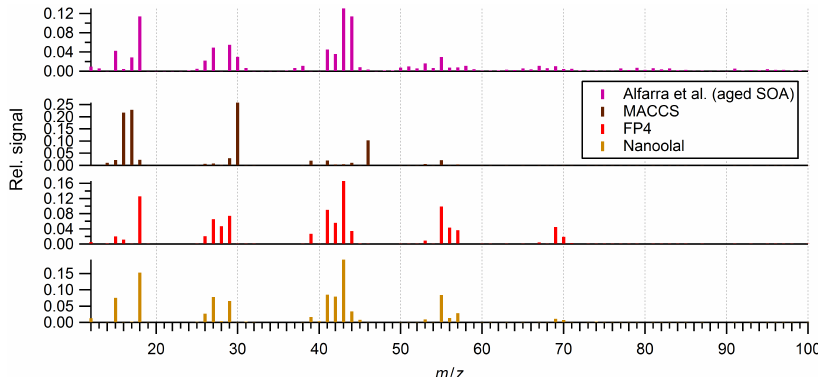
Figure 7. Comparison of the predicted mass spectra of α -pinene SOA based on the GECKO-A simulation presented by Valorso et al. (2011) using various fingerprinting techniques. These are compared with an actual α -pinene SOA mass spectrum obtained by Alfarra et al. (2013) during a chamber